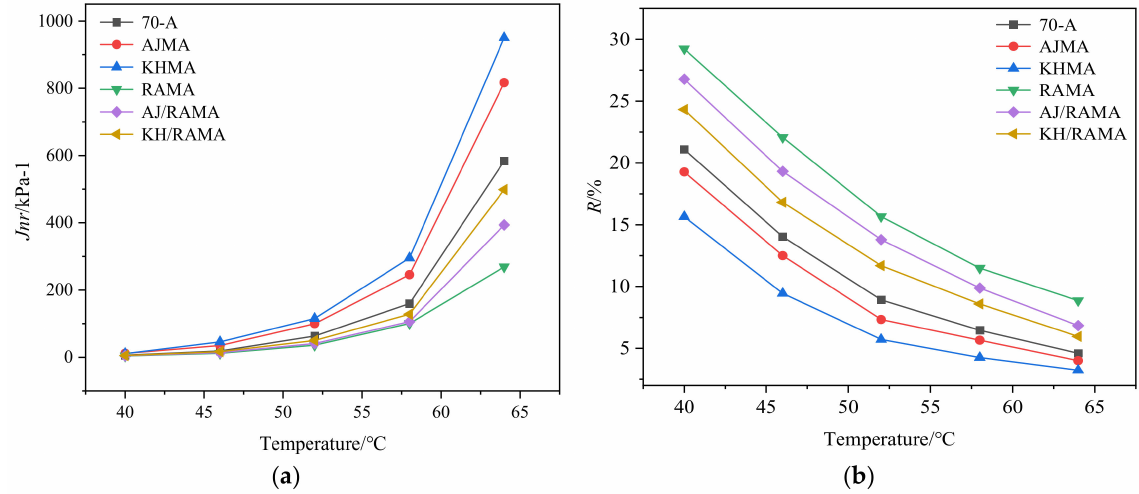
Figure 5. 0.1 kPa stress level: ( a ) Irrecoverable creep compliance; ( b ) Creep recovery